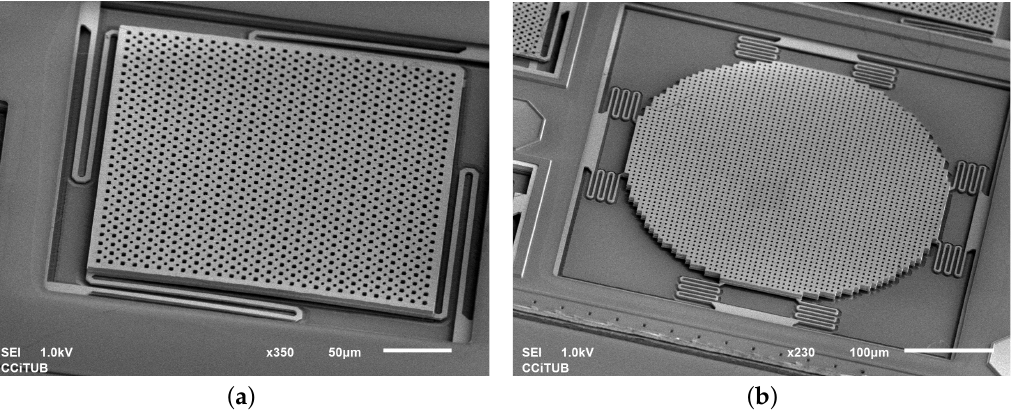
Figure 13. Selected Z -axis devices on on Bailed chip: 04 ( a ); and P ( b